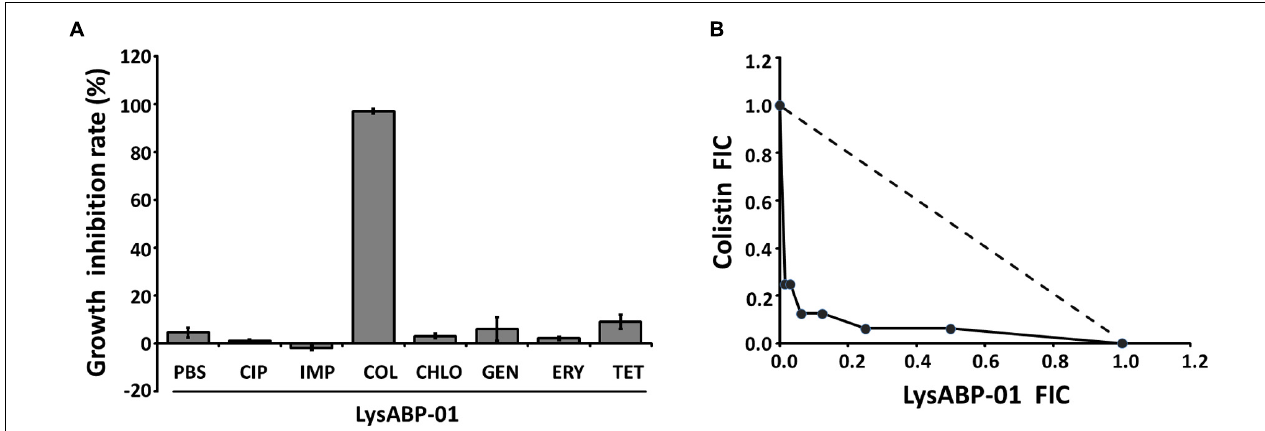
FIGURE 4 | The results of screening and confirmatory testing for synergistic interaction. (A) The growth inhibition rate (the bar graph) of LysABP-01 combined with seven antibiotics. Data are expressed as the mean percentage ± SD of triplicate experiments. Phosphate buffer saline (PBS), ciprofloxacin (CIP), imipenem (IMP), colistin (COL), chloramphenicol (CHLO), gentamycin (GEN), erythromycin (ERY) and tetracycline (TET). (B) The isobologram of the checkerboard assay. FIC values derived from combinations of LysABP-01 and colistin were used to plot the isobologram. The dashed line illustrates the theoretical additive interaction between two